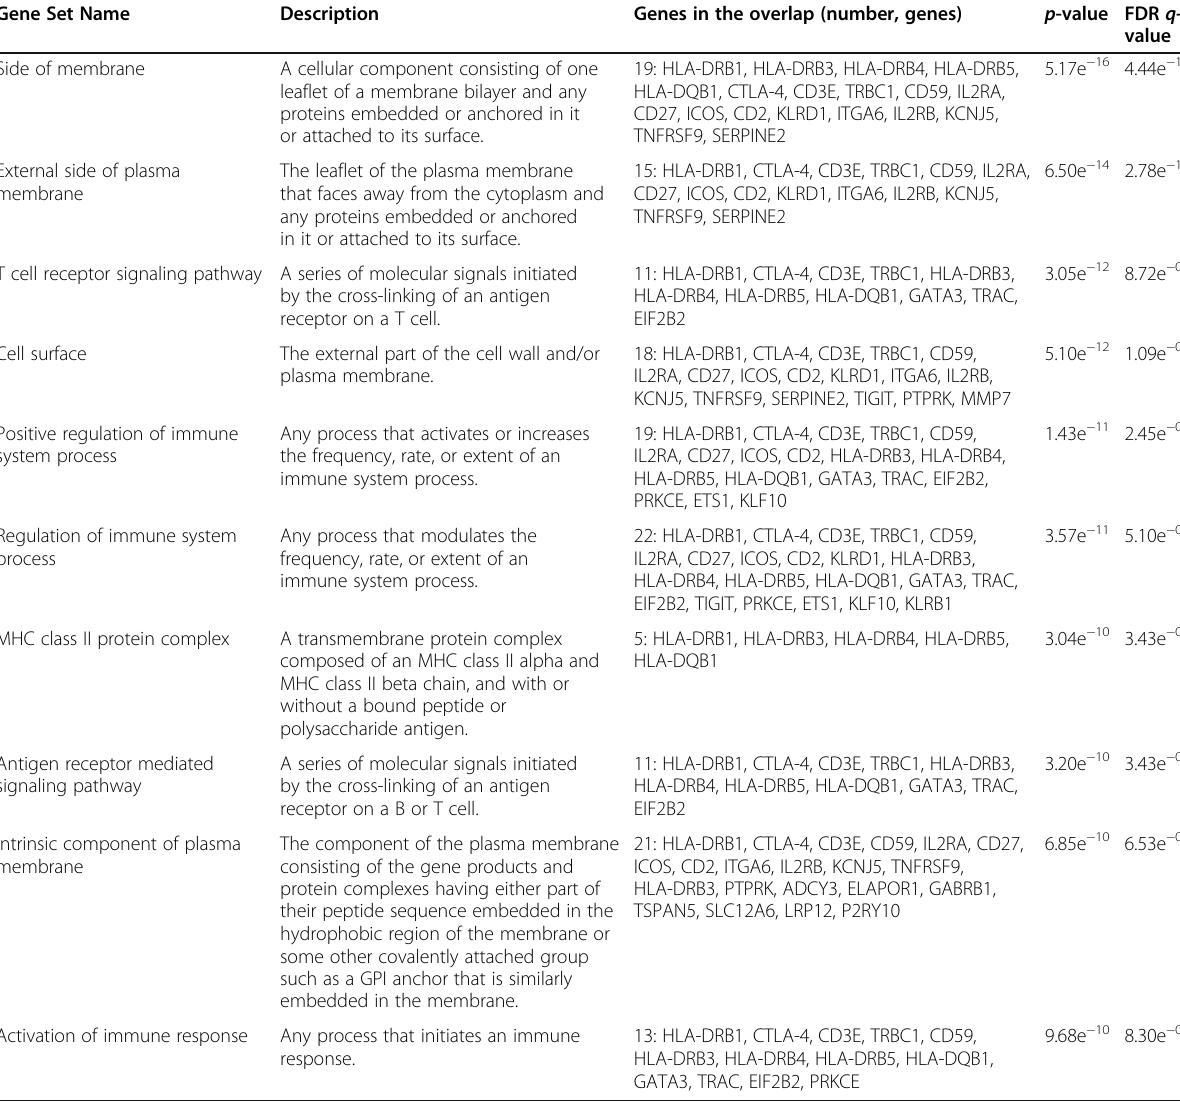
Table 1 Analysis of the overlap of the cured genes with GO: biological processes and cellular components annotated sets in MsigDB